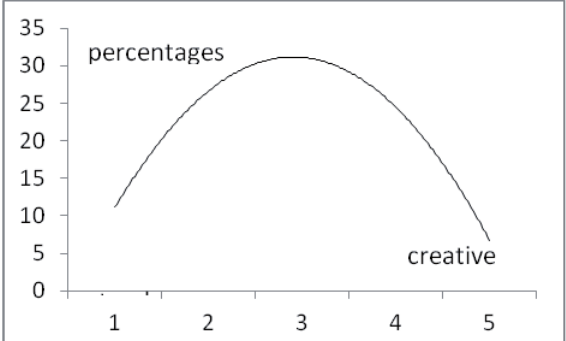
Figure 2. Distribution of student answers on the con- tinuum “Test tasks are standard (1) to creative (5).